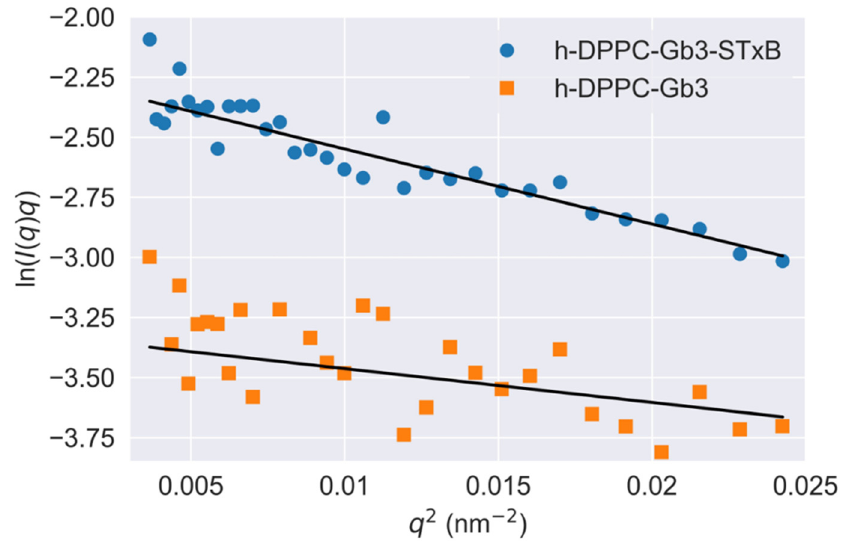
Figure 5. Guinier plots (ln q I( q ) vs. q 2 ) on Gb3 reconstructed DPPC vesicle and Shiga toxin B subunit incubated with Gb3 reconstructed DPPC vesicle. The SUV were prepared as [Gb3]/[DPPC] = 0.1/1 for [h-DPPC]/[d-DPPC] = 0/1. Measurements were performed at T = 25 °C.